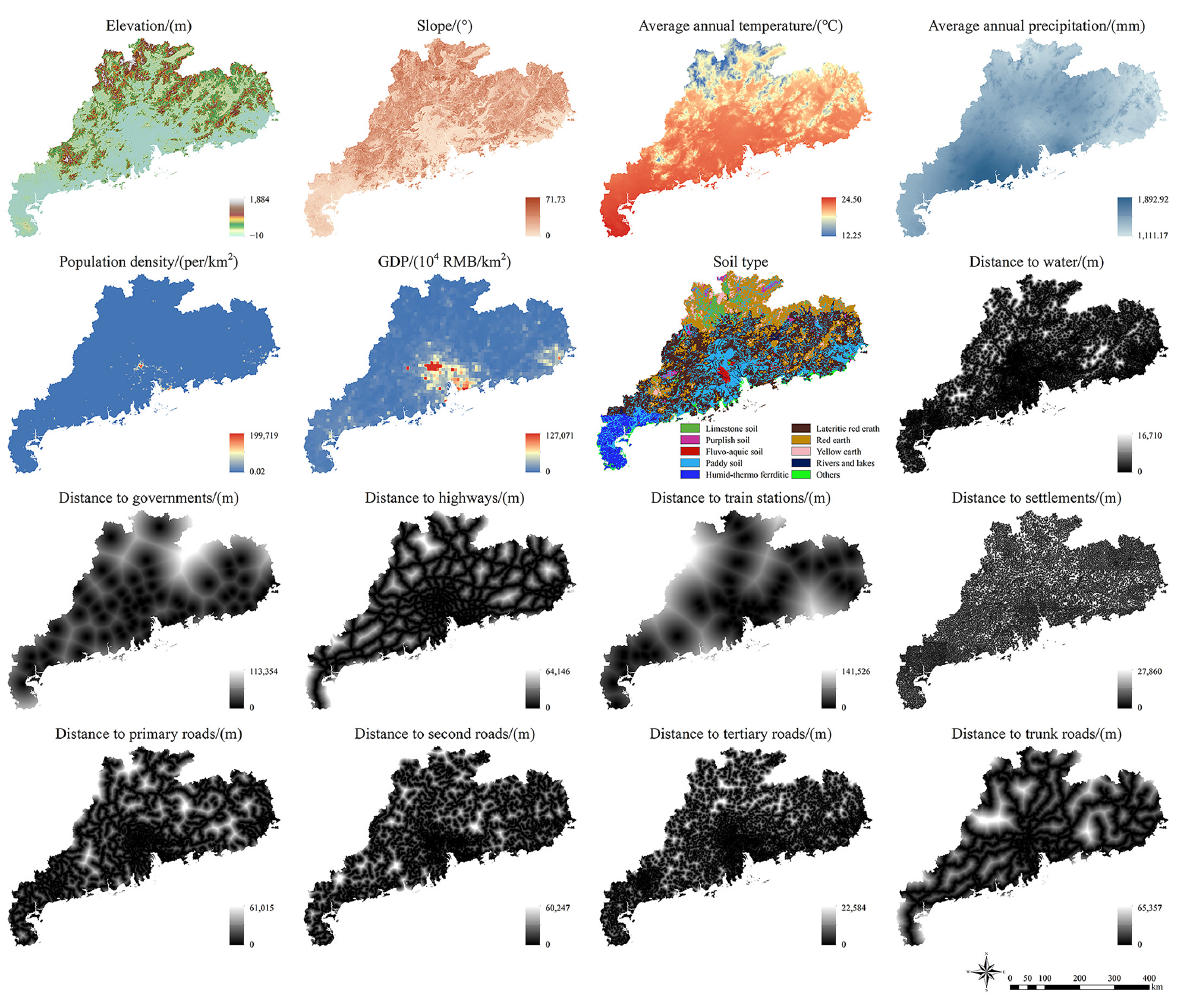
Figure 4. Sixteen types of driving factors affecting LUCC.